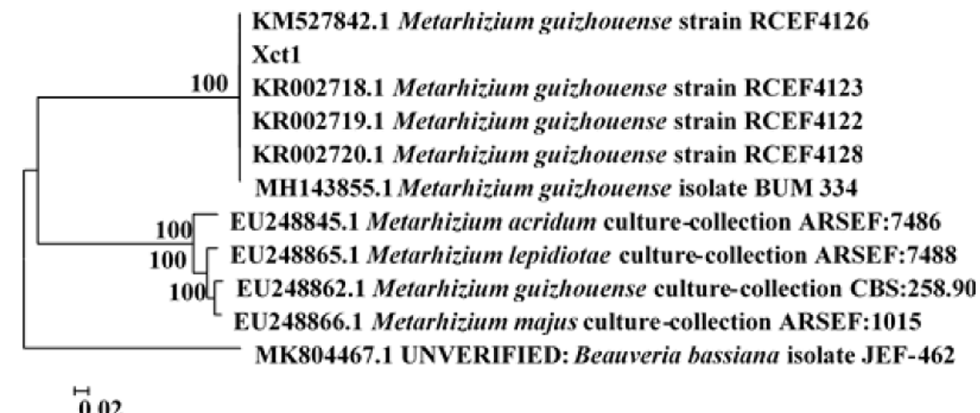
Fig. 5 Evolutionary tree of Xct1 strains and Metarhizium anisopliae taxa based on EF